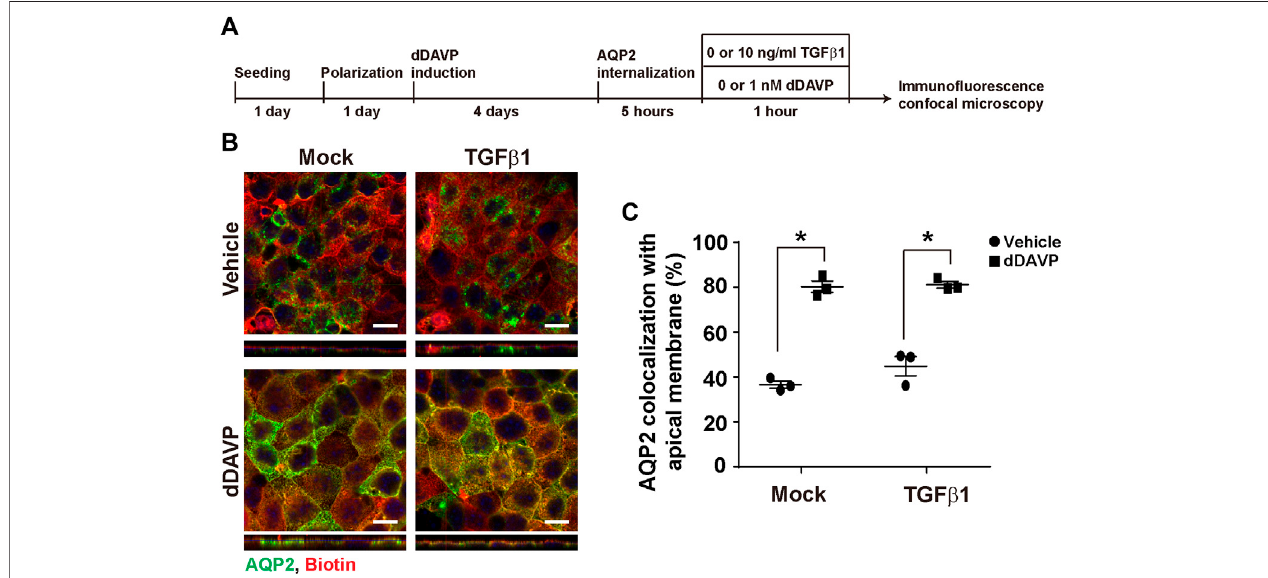
FIGURE 7 | TGF β 1 did not affect vasopressin-induced apical AQP2 traf fi cking. (A) Experimental protocol. (B) Representative confocal immuno fl uorescence micrographs of AQP2(green) and surface-biotinylated apical membrane (red) ofmpkCCD cells in response tovehiclevs. dDAVP (1 nM, 1 h) in the absence or presence of TGF β 1 (10 ng/ml). Scale bars represent 10 μ m. (C) Summary of the imaging results. Values are mean ± S. E. summarized from three independent experiments. Asterisks indicate statistical signi fi cance ( p < 0.05, t